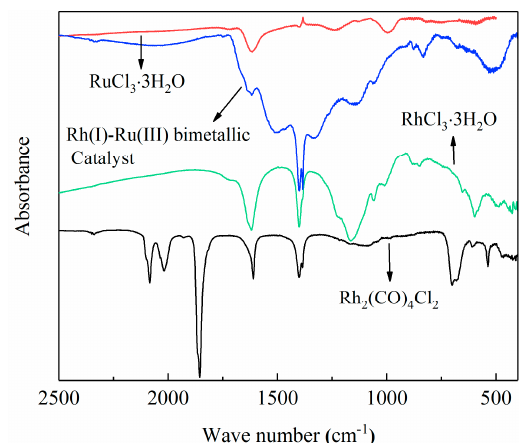
Figure 6. FTIR spectra of different catalysts. Blue line: FTIR spectra of Rh(I)/Ru(III) bimetallic catalyst; green line: FTIR spectra of RhCl 3 · 3H 2 O; red line: FTIR spectra of RuCl 3 · 3H 2 O; black line: FTIR spectra of (Rh 2 (CO) 4 Cl 2 ).